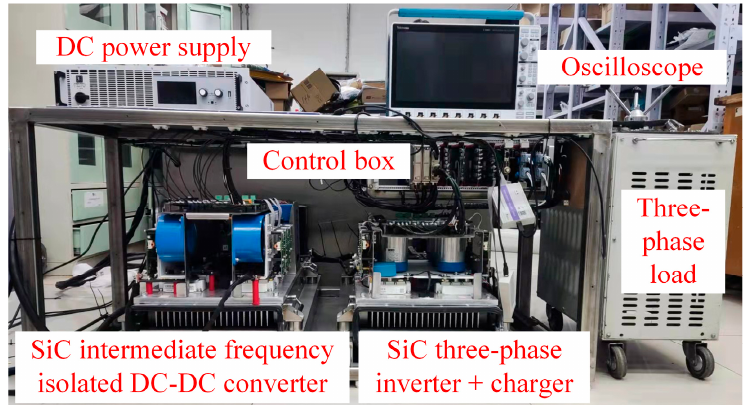
Figure 13. Experimental prototype and platform.